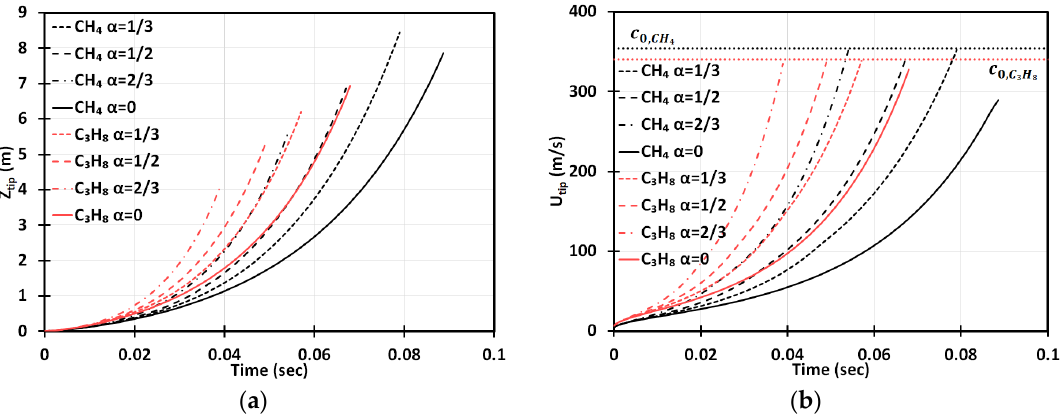
Figure 2. Time evolution of the flame tip position Z tip ( a ) and velocity U tip ( b ) in a 2D geometry for stoichiometric ( φ = 1) methane (CH 4 )-air and propane (C 3 H 8 )-air burning with various blockage ratios α = 0,1/3,1/2,2/3.